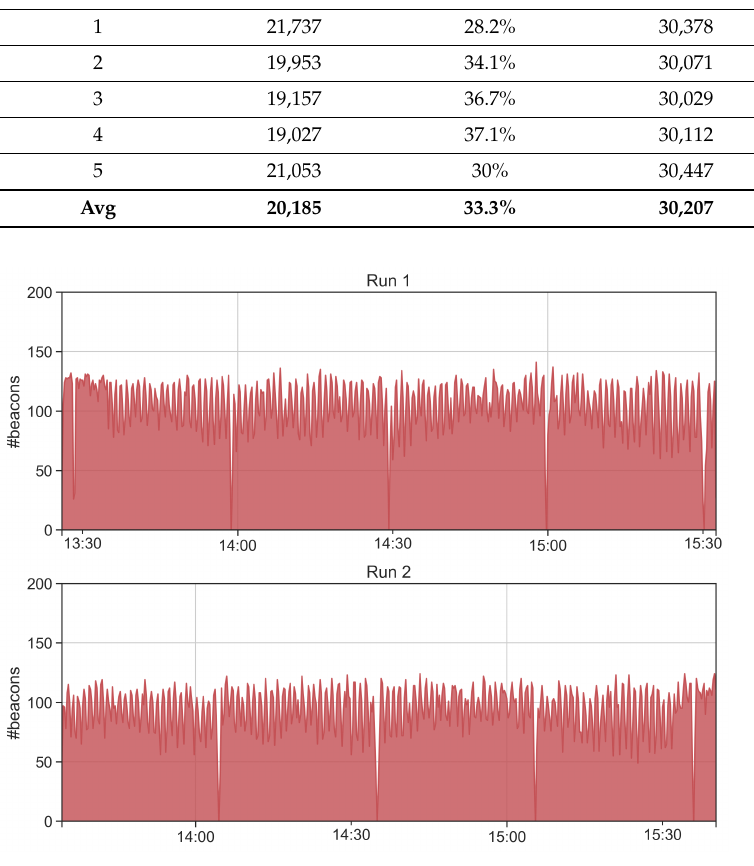
Figure 7. Cumulative number of beacons collected in T 2 for each